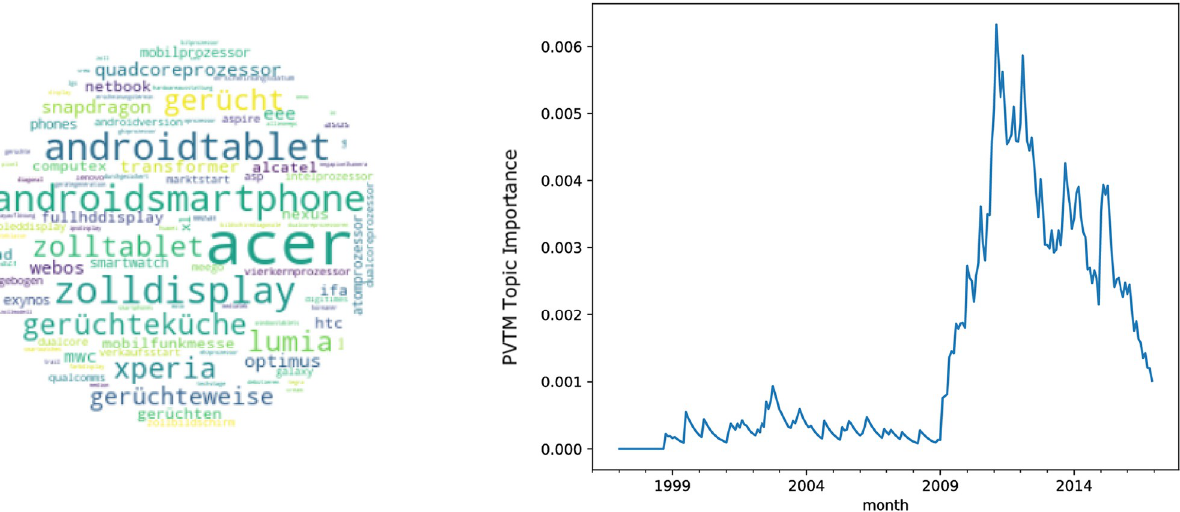
Fig 3. Topic tablet. A: Most relevant words. B: Monthly observations of the topic importance over time, smoothed using a 12-month exponentially weighted moving average.